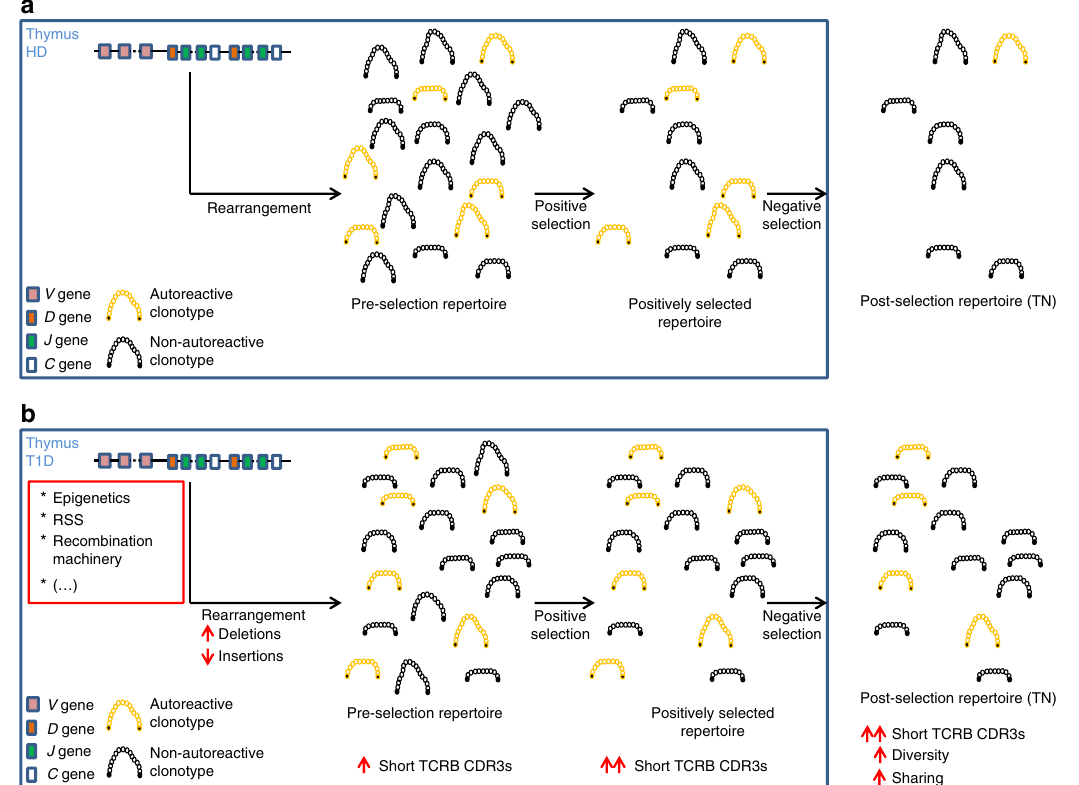
Fig. 9 Proposed model of TCRB rearrangement and selection. a In healthy donors (HD) a random combination of VDJ genes undergoes rearrangement (see Supplementary Fig. 12 for a more detailed explanation of the rearrangement process), yielding a pre-selection repertoire of short and long TCRB CDR3s. Positive selection enriches for short TCRB CDR3s, and negative selection deletes most of the autoreactive clonotypes (orange), generating a polyreactive post-selection repertoire (true naive cells). b In type 1 diabetes (T1D) patients, alterations in TCRB rearrangement cause the generation of higher frequencies of shorter TCRB CDR3s, bearing long deletions and short insertions. Positive selection enriches for shorter TCRs, and therefore the input of TCRB chains into negative selection is higher than in healthy donors. Published alterations in negative selection suggest that in T1D a notable proportion of autoreactive clonotypes do not get deleted. The fi nal outcome is a more diverse post-selection repertoire, enriched in shorter clonotypes, highly shared and containing autoreactive clonotypes. Black dots in clonotypes represent the conserved C and F amino acids in the 5 ′ and 3 ′ ends of the TCRB CDR3, respectively. White dots represent amino acids other than the conserved C and F. To ease the interpretation of the model only the CDR3B loop of the TCRB chain is shown, and the rearrangement of the TCRA chain has been